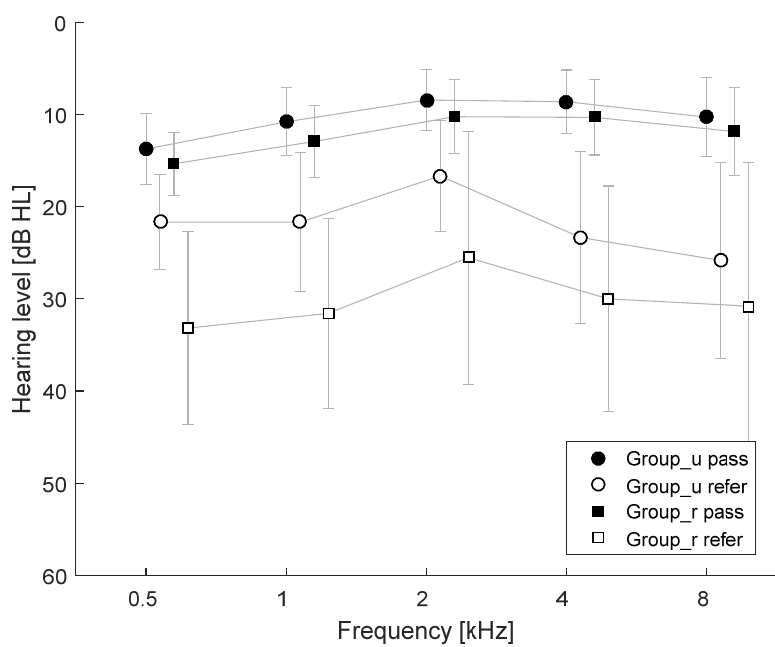
Figure 1. Average hearing thresholds for Group_u (urban) and Group_r (rural) divided into normal hearing (pass) and hearing loss (refer) subgroups.